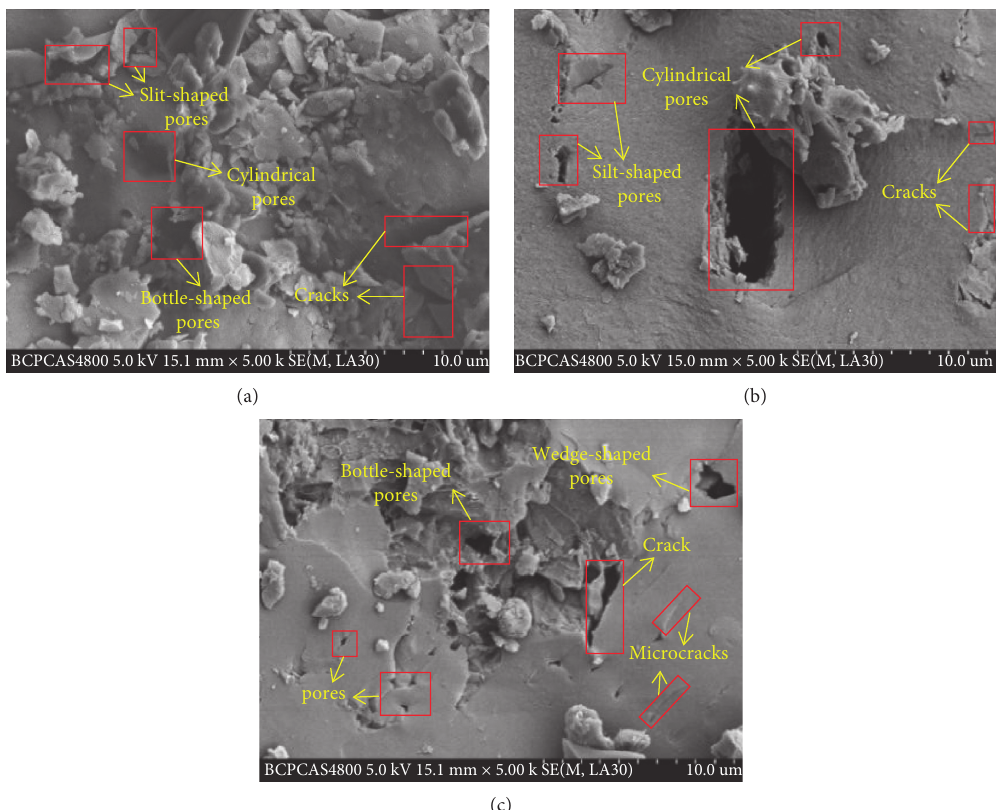
Figure 5: The SEM image at 5000 magnification. (a) Dashucun. (b) Sihe. (c)